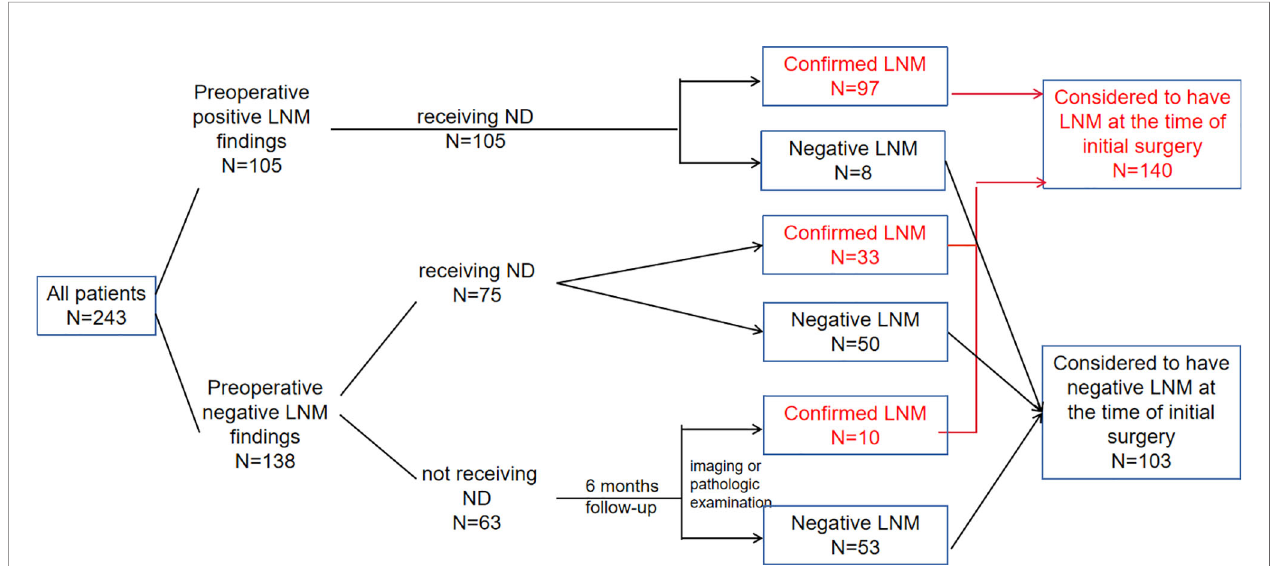
FIGURE 1 | Treatment management, postoperative pathology and follow-up information for patients in the training